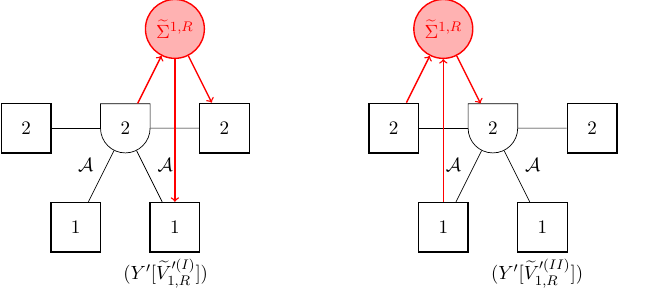
in the flavored R